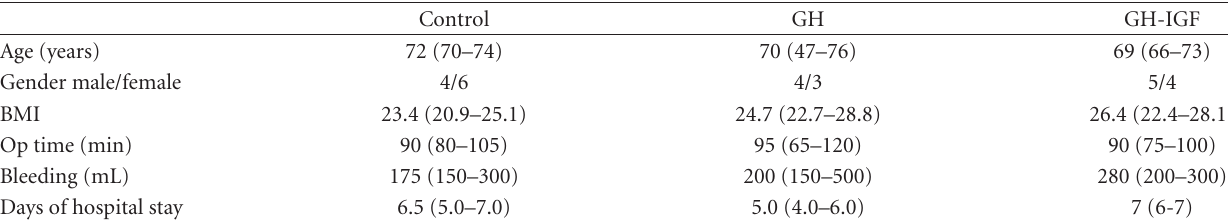
Table 1: Characteristics of the